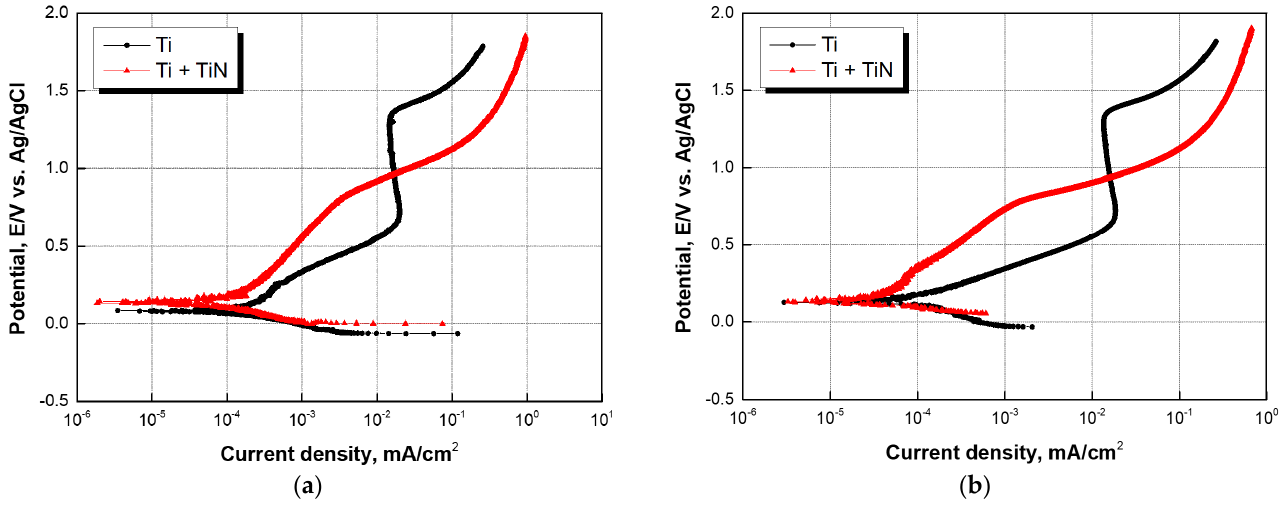
Figure 4. Potentiodynamic polarization curves of titanium substrate and TiN-coated specimen in simulated PEMFC environment; ( a ) Cathode (air bubbling); ( b ) Anode (H 2 bubbling).